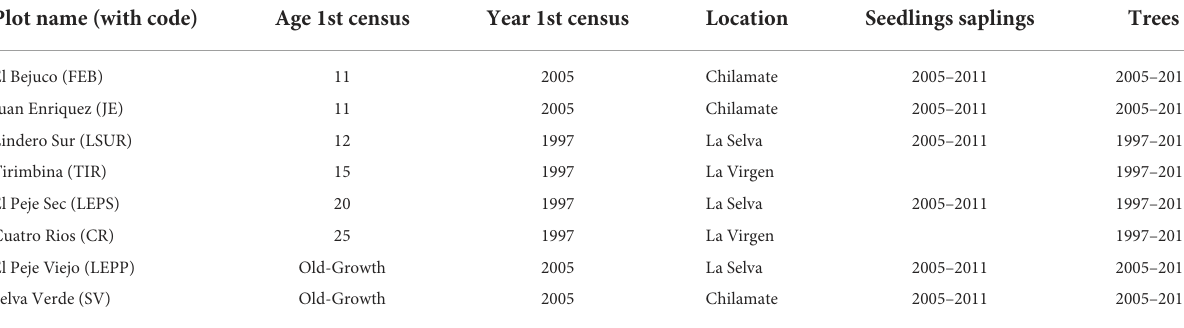
TABLE 1 Plot characteristics and data